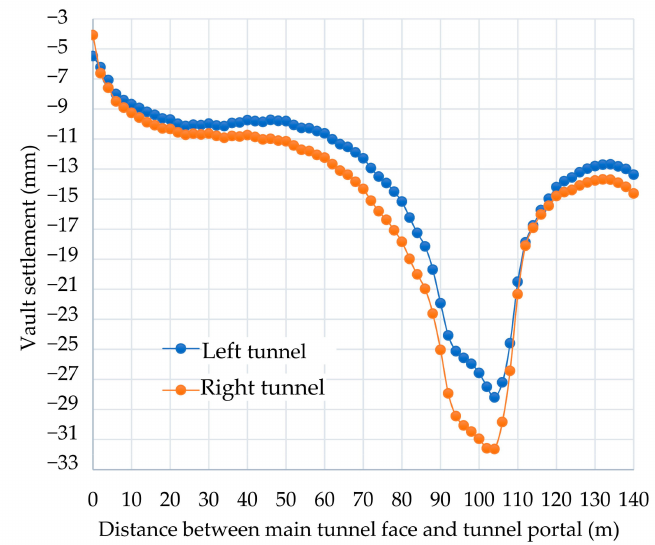
Figure 18. Vault settlement of the main tunnel.